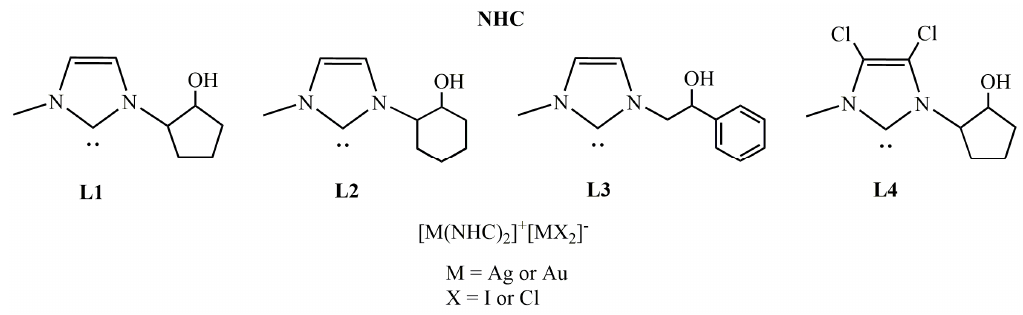
Figure 1. NHC ligands and Ag and Au respective complexes.